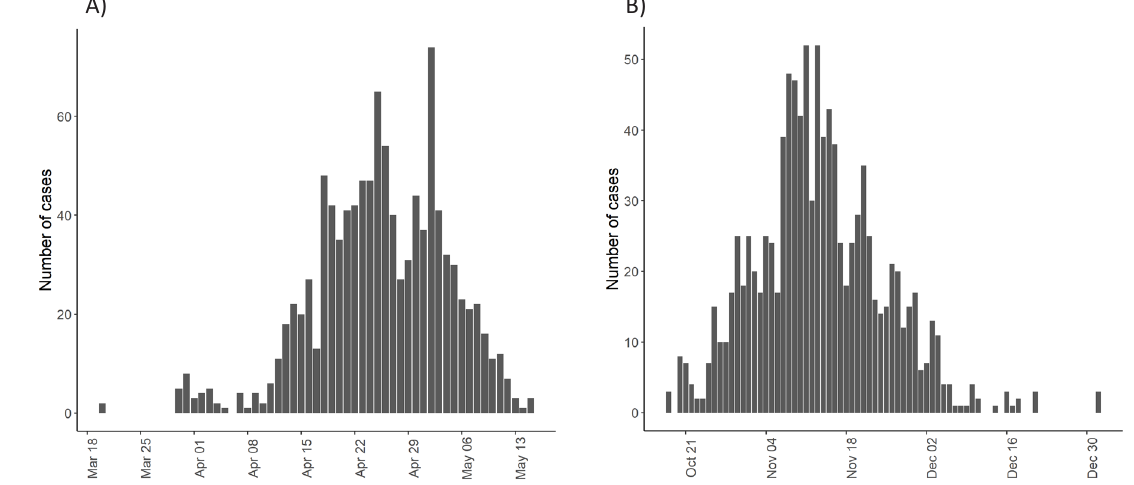
Fig. 5. Dates of 30-day average air temperature transition through 5 °C in Lithuania during spring (A) and fall (B),